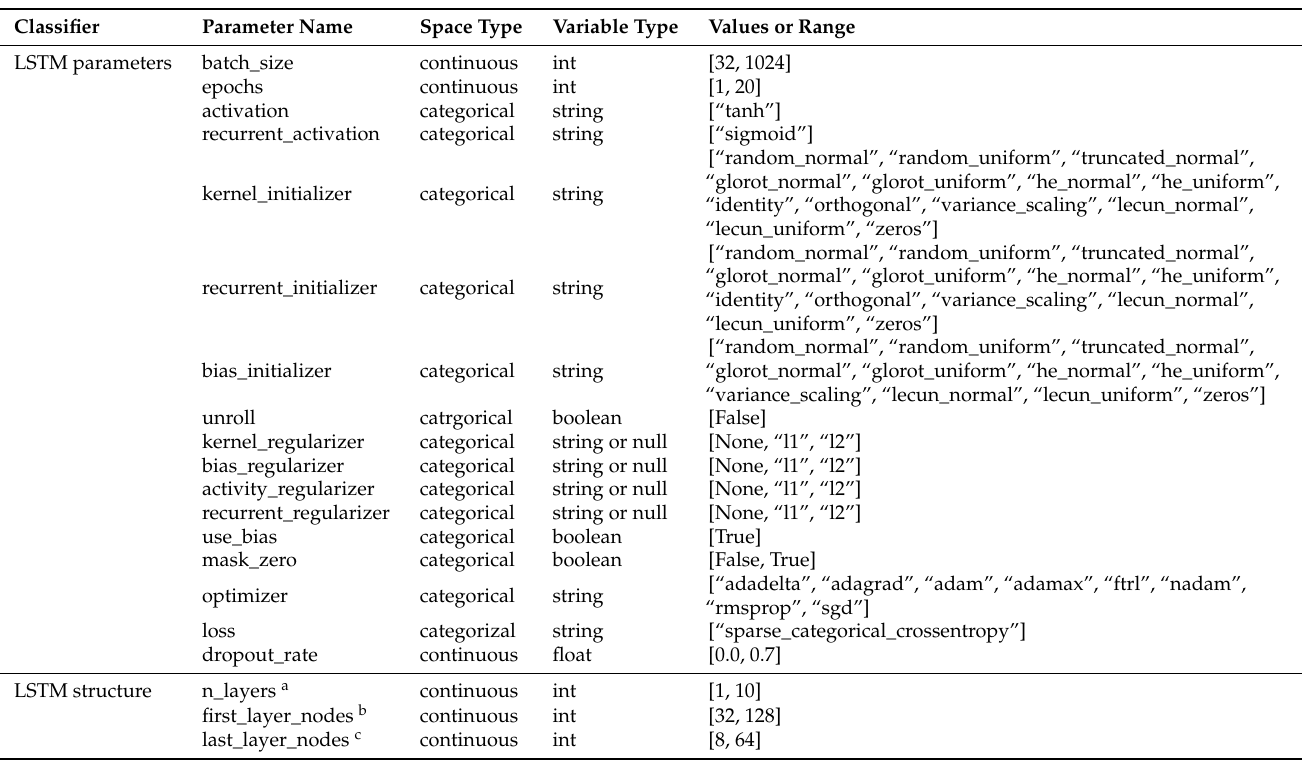
Table A4. Parameters and their values and ranges considered for EO hyperparameter search: the case of